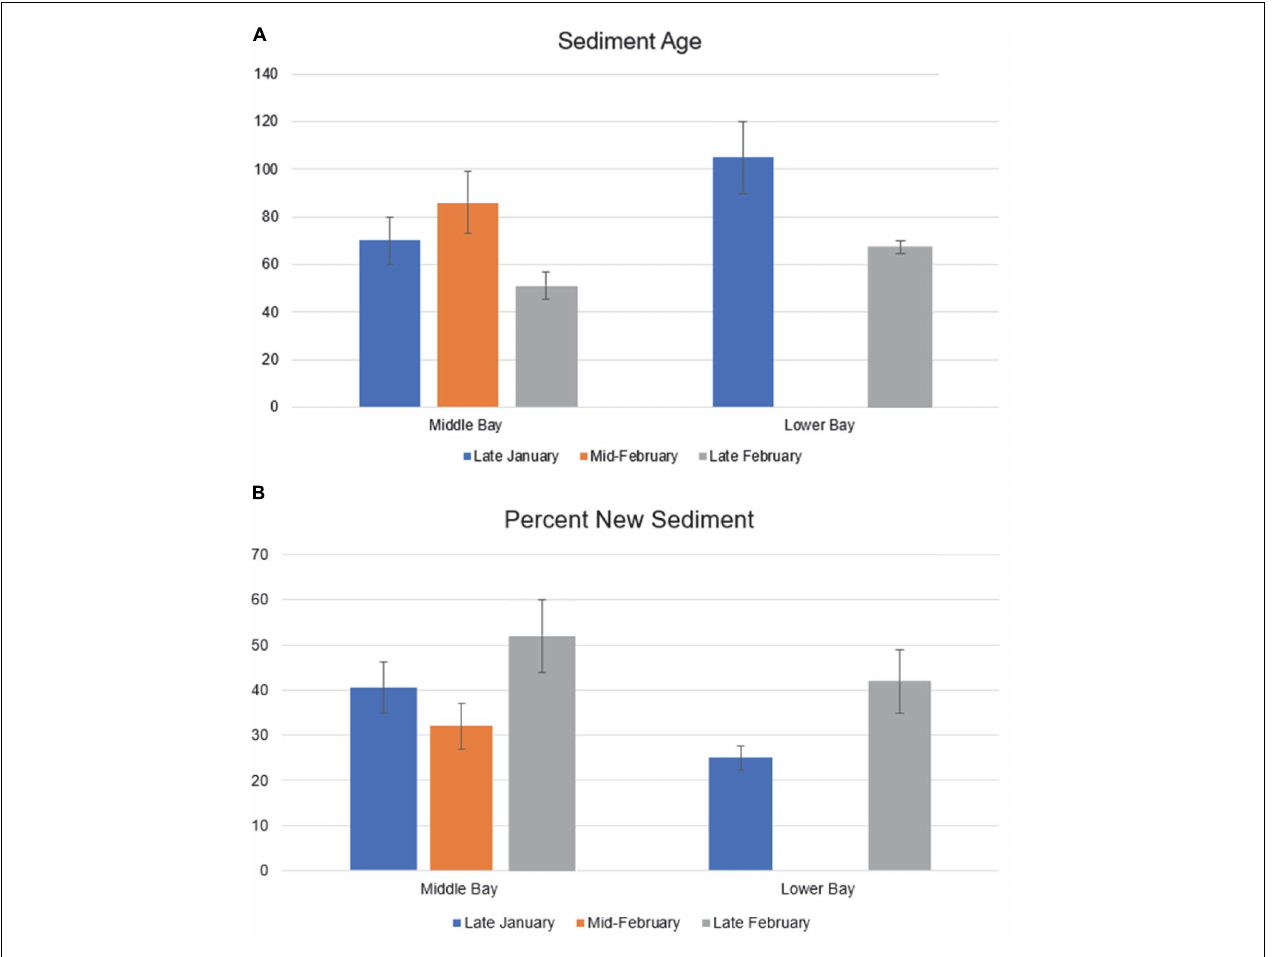
FIGURE 3 | Age of suspended sediments (A) and Percent “New” sediments (B) in middle and lower Galveston Bay during three weather events at